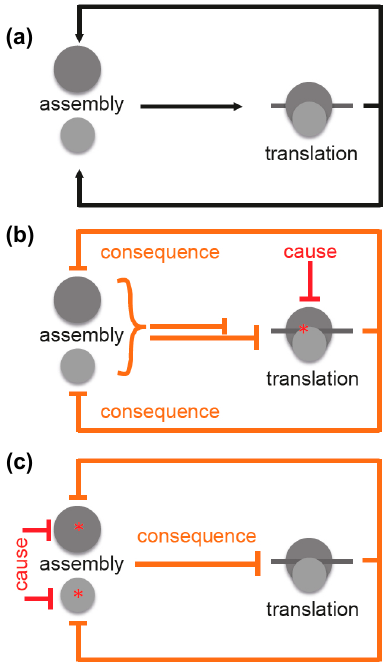
Figure 4. Scheme illustrating interconnectivity of ribosome assembly and translation. ( a ) ribosome assembly is the prerequisite for translation, which in turn is required for ribosome assembly; ( b ) inhibition of translation by a translation inhibitor is the causative mechanistic element. As a consequence, this results in inhibition (or at least reduction) of the assembly process, which, in turn, inhibits translation completing the negative feedback loop. Both processes are clearly interconnected in vivo and underlie complex regulation; ( c ) inhibition of ribosomal subunit assembly by a putative primary assembly inhibitor acting on one of the two subunits (cause) will result in inhibition of translation (consequence), which additionally inhibits assembly. This also creates a negative feedback loop. Legend: Black lines with arrows: positive effects; red lines: direct (causative) inhibitory effects; orange lines: resulting (consequent) inhibitory effects; asterisks: site of inhibition; dark gray circle: large ribosomal subunit; light gray circle: small ribosomal subunit; dark gray line: mRNA.